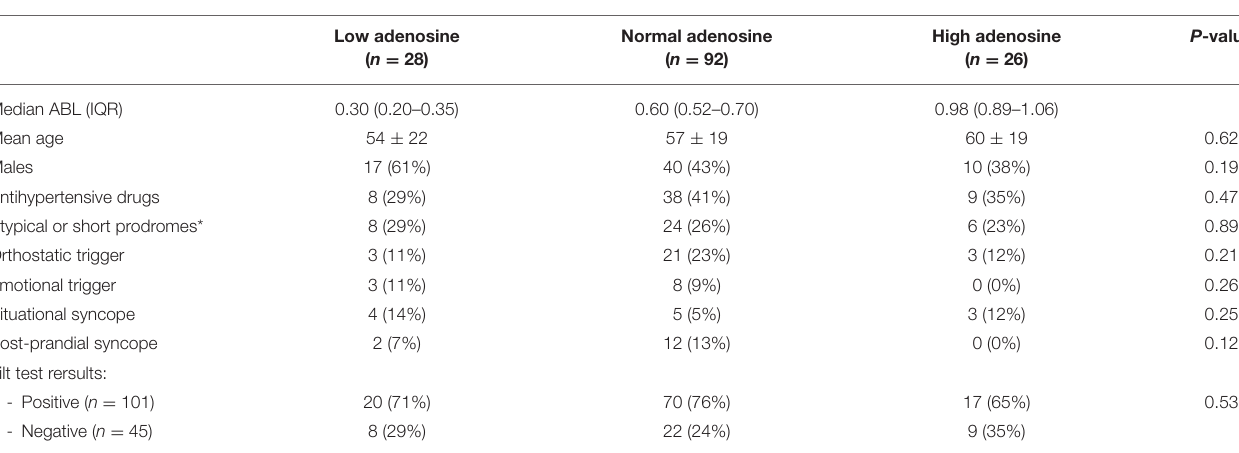
TABLE 2 | Clinical features according to adenosine